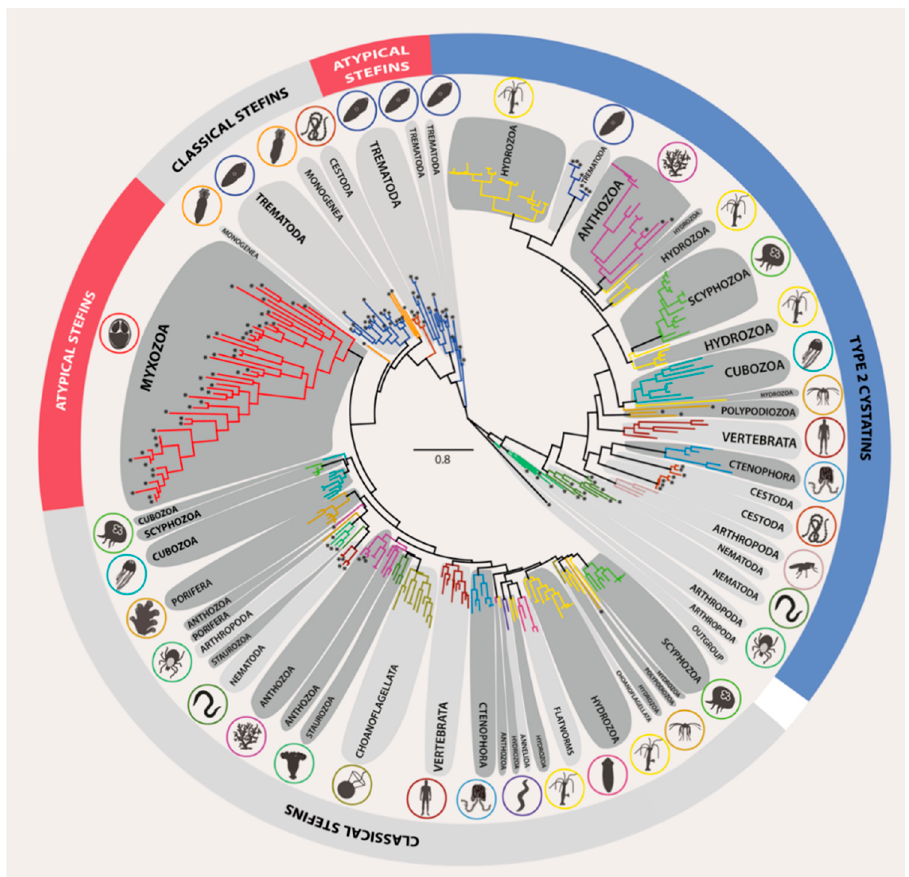
Figure 3. Maximum likelihood phylogenetic tree of the cystatin superfamily represented in the Metazoa and Choanoflagellata. Giardia cystatin was used as the outgroup. The basal metazoan groups are depicted in dark grey shaded bubbles, while other groups are shaded light grey. Cystatin homologues from parasite taxa are labelled by asterisks at the tip of the nodes. The detailed ML and BI phylogenetic trees featuring taxa names and all nodal supports are provided in Figure S1.